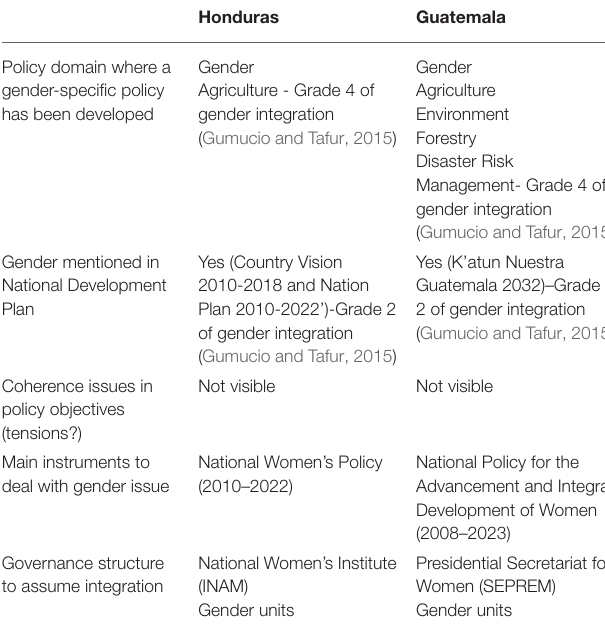
TABLE 2 | Characteristics of gender integration within policy mix of gender, agriculture, CC and FSN and National Development plans in Guatemala and